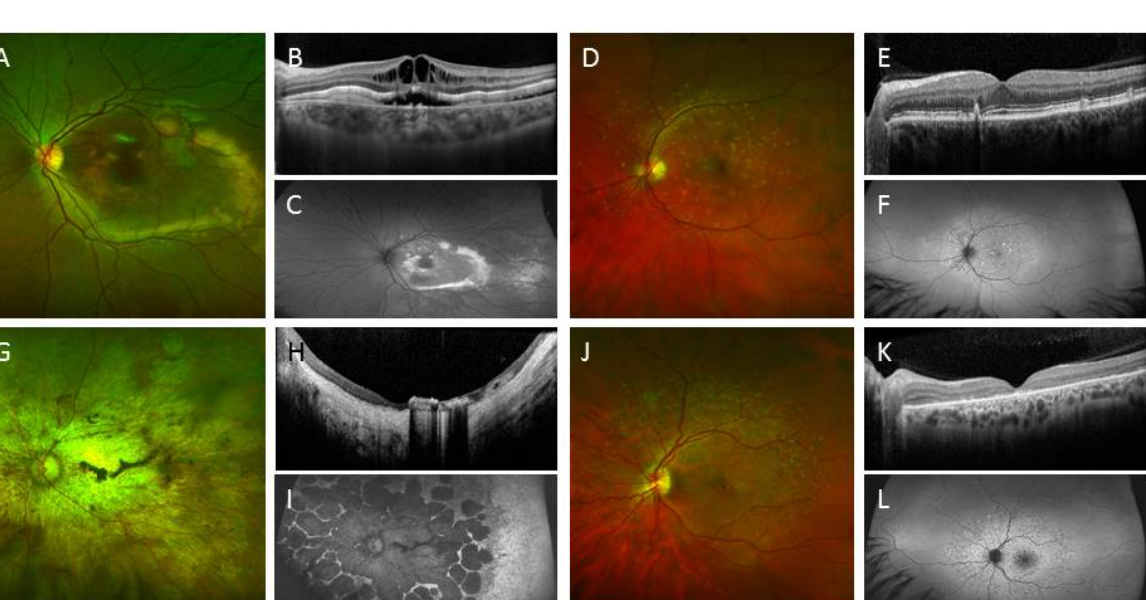
Figure 6. Clinical images of various types of inherited retinal diseases. ( A ) Colour photograph of the macula of a 10-year-old boy showing multifocal vitelliform lesions resulting from homozygous deletion of exon 2–6 of the BEST1 gene; ( B ) Optical coherence tomography (OCT) shows intraretinal cystic change with sub-retinal fluid and vitelliform deposits; ( C ) Increased fundus autofluorescence was noted in the area of vitelliform deposits; ( D ) Colour photograph of the macula of a 57-year-old male showing yellow deposits due to pattern dystrophy of the retinal pigment epithelium (RPE); ( E ) OCT shows deposits above and below the RPE; ( F ) Multifocal hyper autofluorescent lesions are seen; ( G ) Colour photograph of the macula of a 56-year-old female showing extensive macular atrophy with cone-rod dystrophy due to two missense mutations in the ABCA4 gene (c.2915 C > A and c.3041 T > G); ( H ) OCT shows severe retinal and choroidal atrophy with pigment migration into the fovea; ( I ) Extensive RPE loss resulting in wide-spread hypo autofluorescent lesions; ( J ) Colour photograph of the macula of a 32-year-old male showing retinal flecks with mild cone dysfunction due to two pathogenic mutations in the ABCA4 gene (c.4139 C > T and c.6079 C > T); ( K ) OCT shows